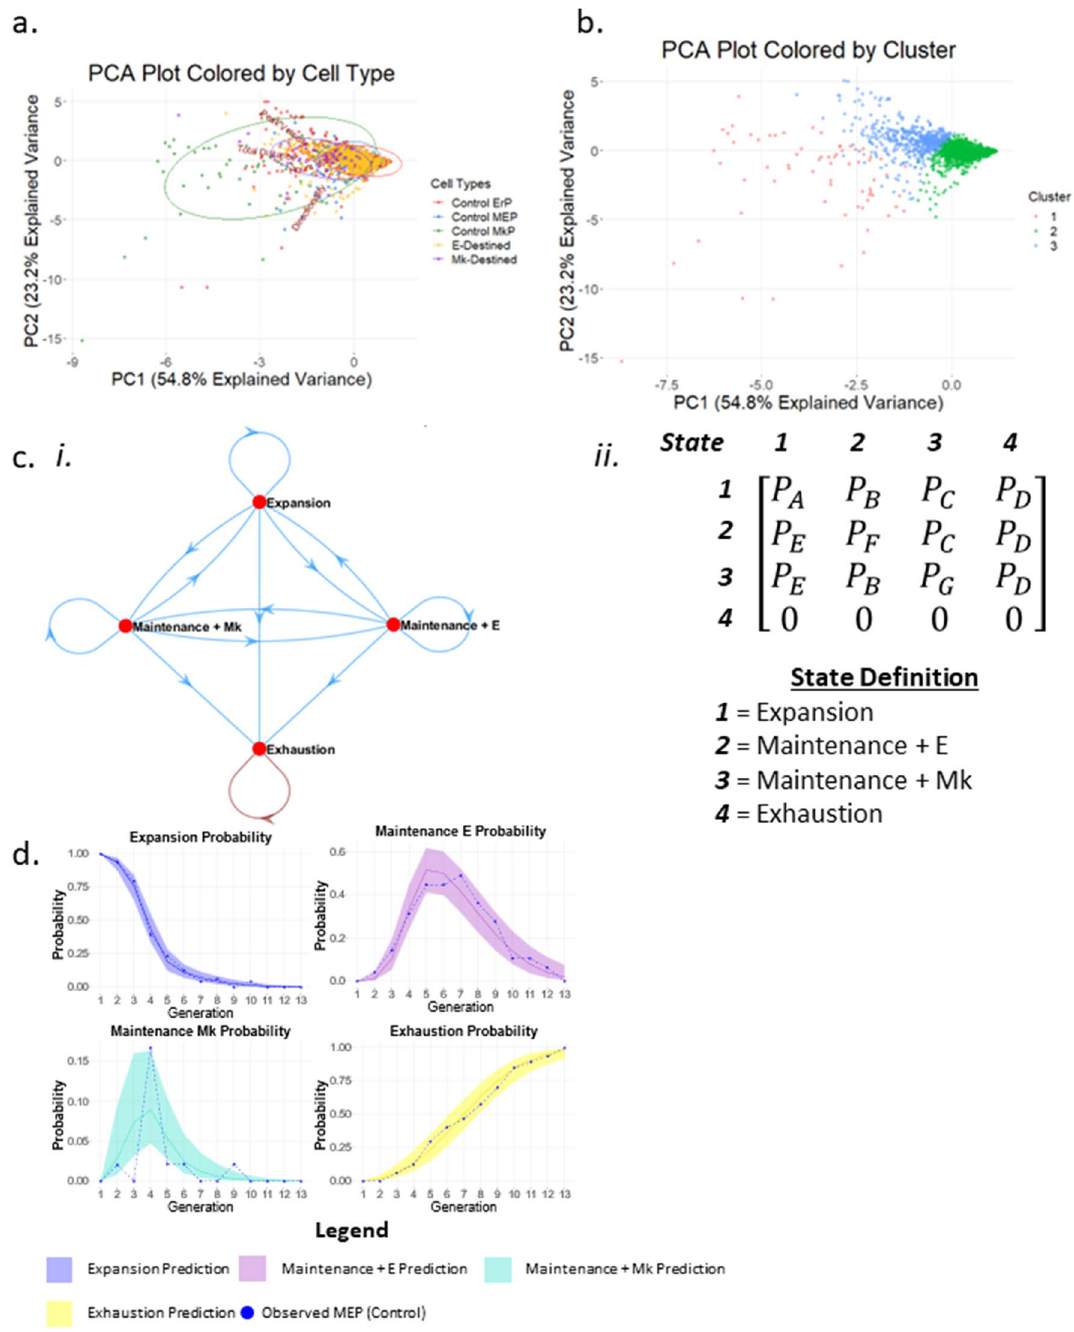
Figure 4. Quantitative behavioral phenotypes predict cell state. ( a ) Clustering of cells based on multi- dimensional analysis. Individual cells are graphed on PCA plots based on all quantified behavioral phenotypes (peak velocity, total distance, lifespan, and directionality) and color coded based on cell state: bipotent MEP (blue), E-destined (orange), Mk-destined (purple), committed ErP (red), and committed MkP (green). ( b ) k-means clustering of PCA plots. Three clusters were generated by k-means clustering. ( c ) Markov chains depicting cell state transitions of MEPs in CFU culture conditions. (i) Markov chains most accurately encompass the cell state transitions MEPs were observed to undergo. States include expansion, maintenance + E, maintenance + Mk, and exhaustion. (ii) The matrix used to derive the mathematical model to predict MEP state transitions. ( d ) Probability of MEP state transitions. The probability that MEPs will undergo four division types (expansion, maintenance + E, maintenance + Mk, exhaustion) by generation in culture is represented by the solid lines in each graph with a 95% confidence interval represented by the colored shadowed regions. Actual observed frequencies of each division outcome by generation are depicted by the dotted